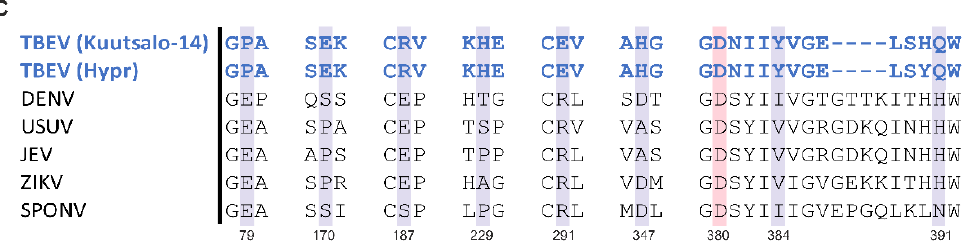
Figure 4. Interactions at the E heterotetramer interface. ( A ) Interactions between the E proteins located at the heterotetramer interface. Chain B is shown in pink, chain A in light green and chain C in grey. The asymmetric units (AU) are labelled. Interacting residues are shown as stick representations and labelled in the close-up views. Hydrogen bonds are shown by green dotted lines. The distance between the interacting residues is labelled. The π -stacking interaction between His347 and Arg187 and the salt bridge between Arg187 (atom-NE) and Asp380 are not shown for clarity. His347 and Arg187 are separated by a distance of 3.4 Å, and Arg187 (atom-NE) and Asp380 by 4 Å. ( B ) A consensus sequence of the interacting E residues in 183 TBEV sequences. Letter size is proportional to the frequency of the residue. Interacting residues are marked with numbers and the residues are coloured according to chemistry (grey, hydrophobic; pink, acidic; purple, polar including glycine; turquoise, basic; magenta, neutral). The wave indicates a sequence break. ( C ) Structure-based sequence alignment of flaviviruses with high-resolution structures. Residues conserved throughout flaviviruses are highlighted with pink, and residues conserved in TBEV isolates are highlighted in grey. The interacting residues are numbered according to TBEV Kuutsalo-14 sequence (GenBank: MG589938.1).